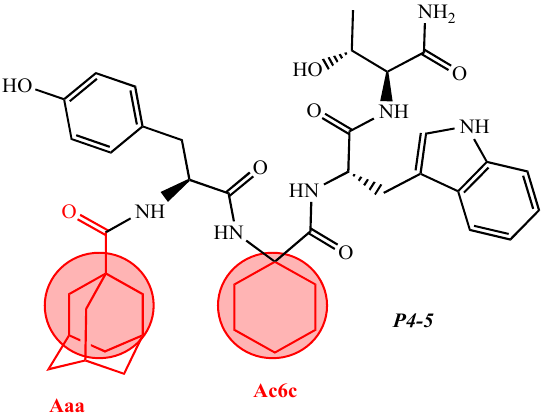
Figure 3. Chemical structure of peptide analog P4-5. Table 2. Quantitative assessment of anticonvulsant activity of hemorphin peptides in the MES test in mice.